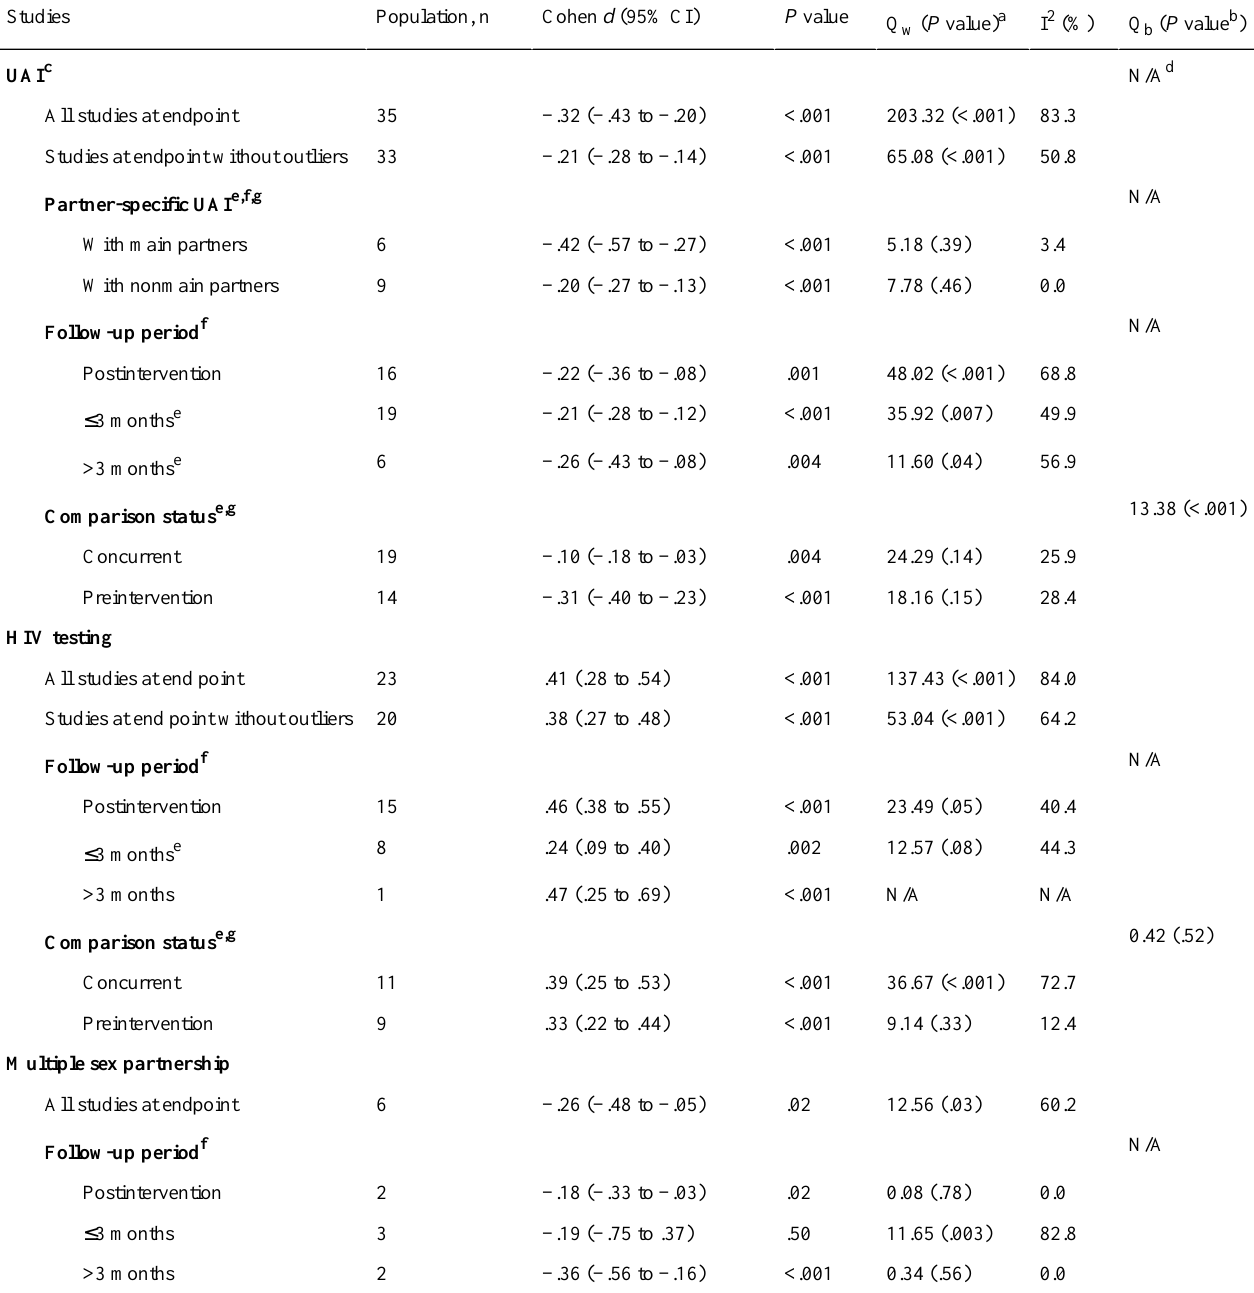
Table 2. Overall effect sizes and stratification by study design